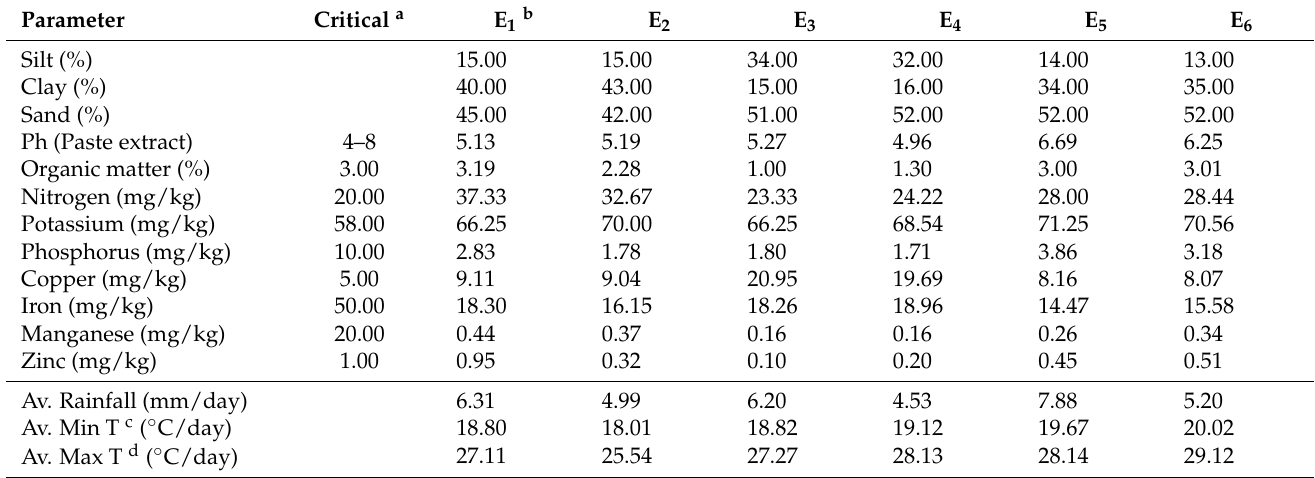
Table 4. Soil and weather characteristics at locations used as six test environments in the yam genotype-by-environment interaction trials.